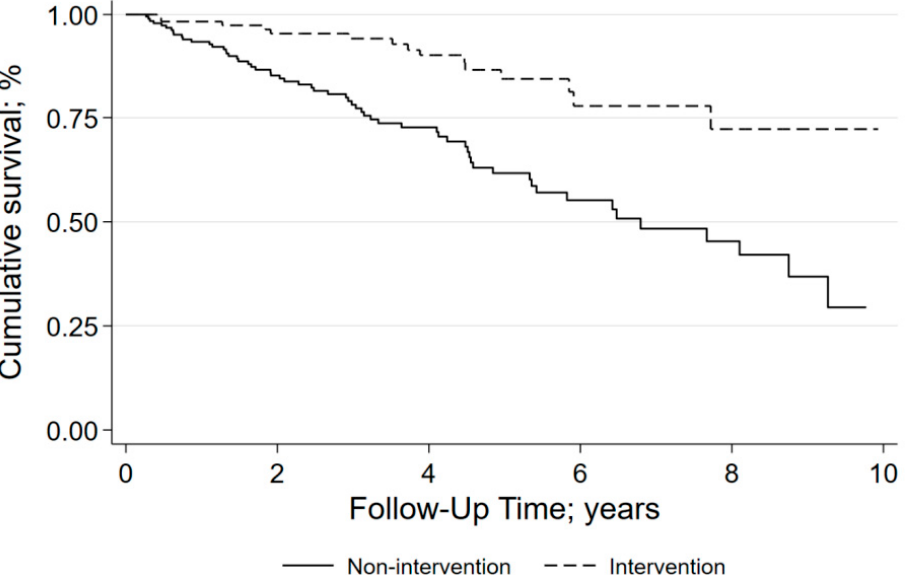
Figure 2. Survival in patients with and without intervention.—Kaplan–Meier curves of cumulative survival stratified by treatment (non-surgical or surgical).